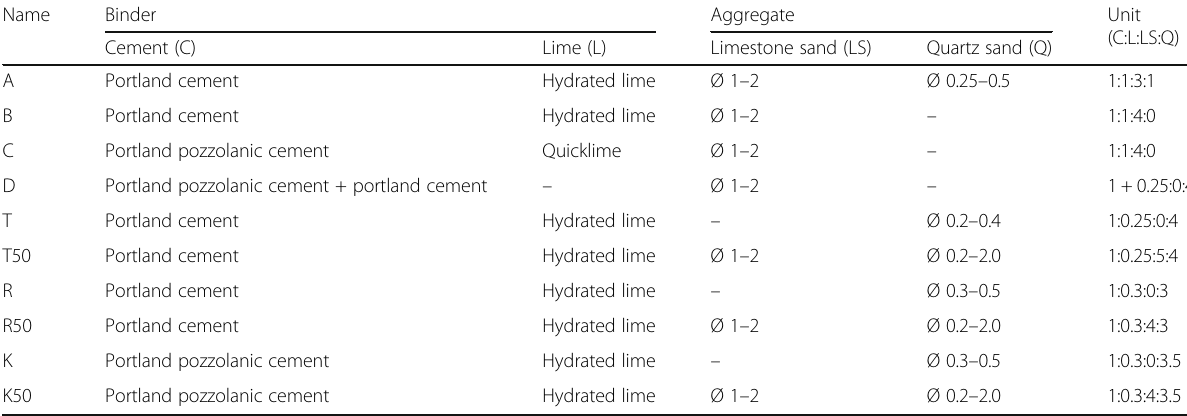
Table 1 Abbreviation and composition of tested mortars